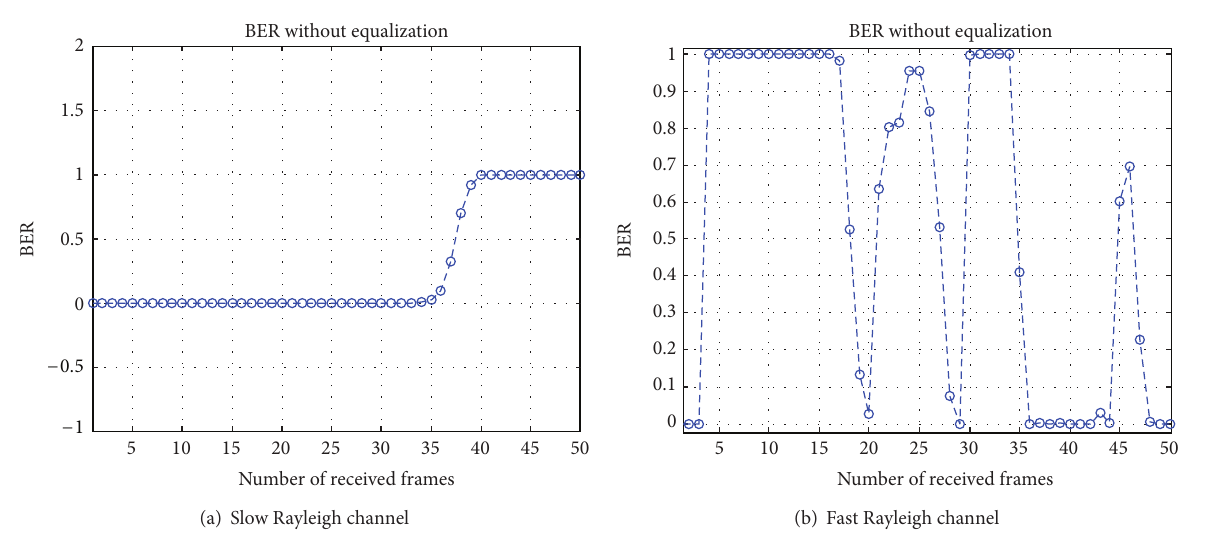
F 10: Variations of the Rayleigh channel: change of the 5 paths in time.